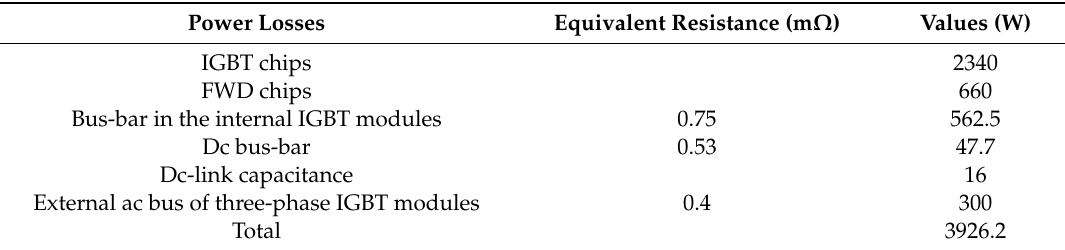
Table 4. Power losses of the inverter.